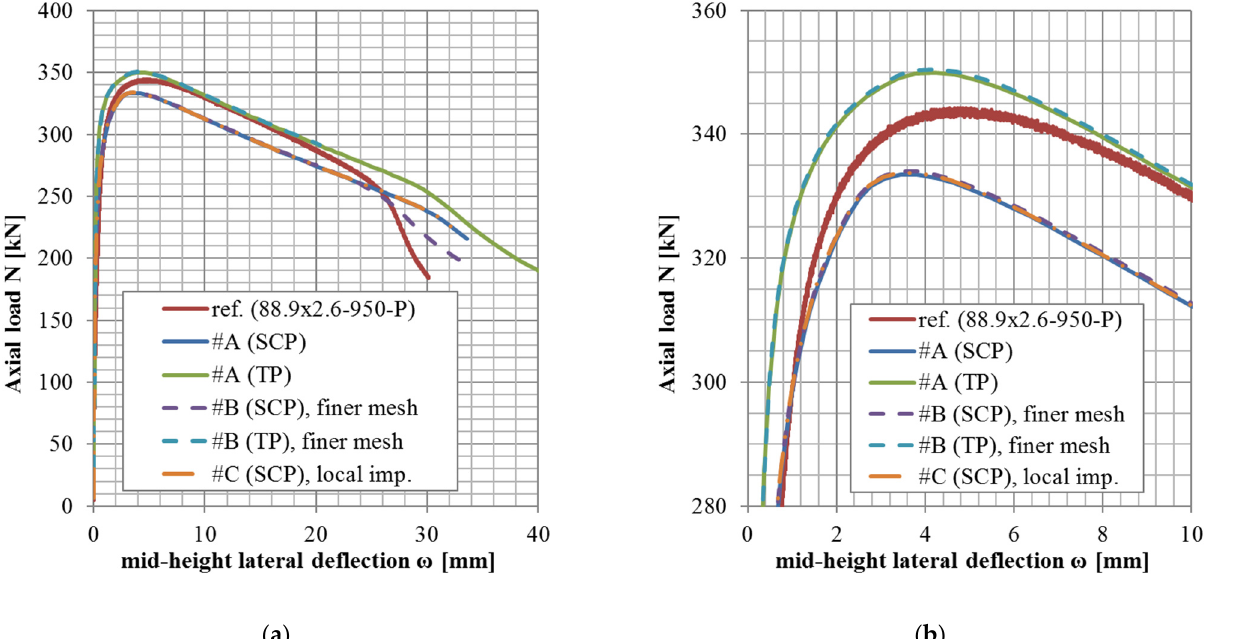
Figure 5. Experimental and FE loads vs. midheight lateral deflection curves of 88.9 × 2.6-950-P [38]: ( a ) whole; ( b ) zoomed.